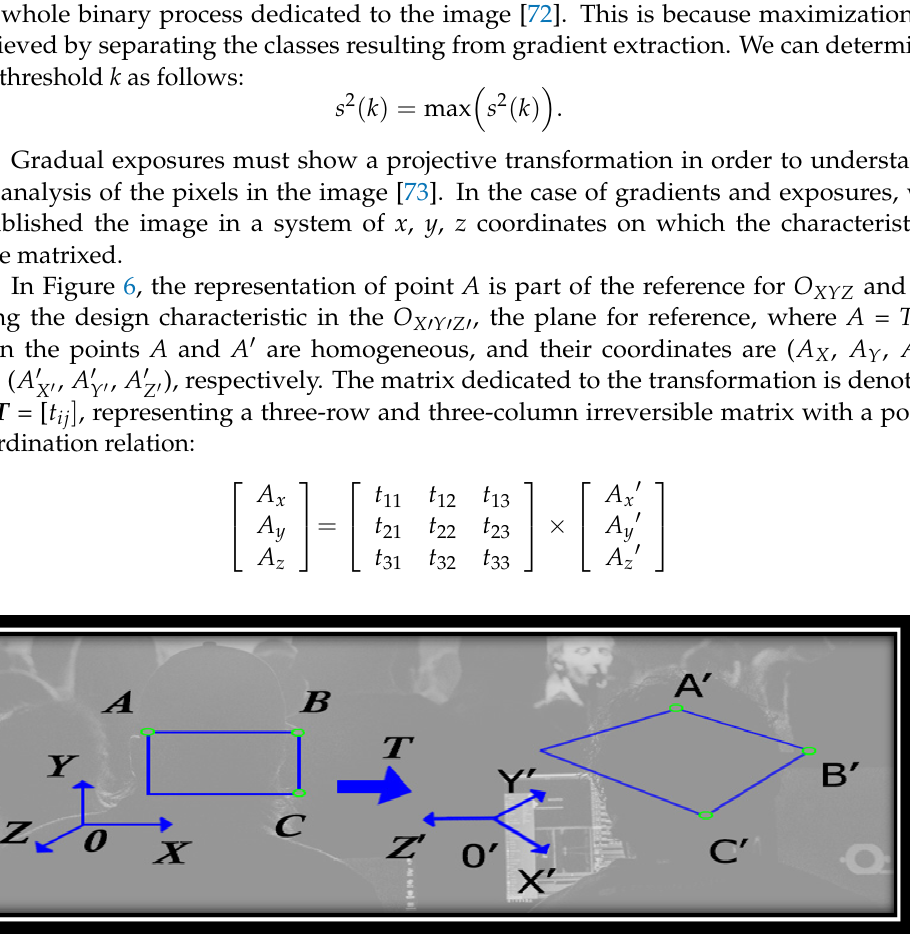
Figure 6. Exemplification of a projective transformation for distorting a rectangle—extraction capabilities.